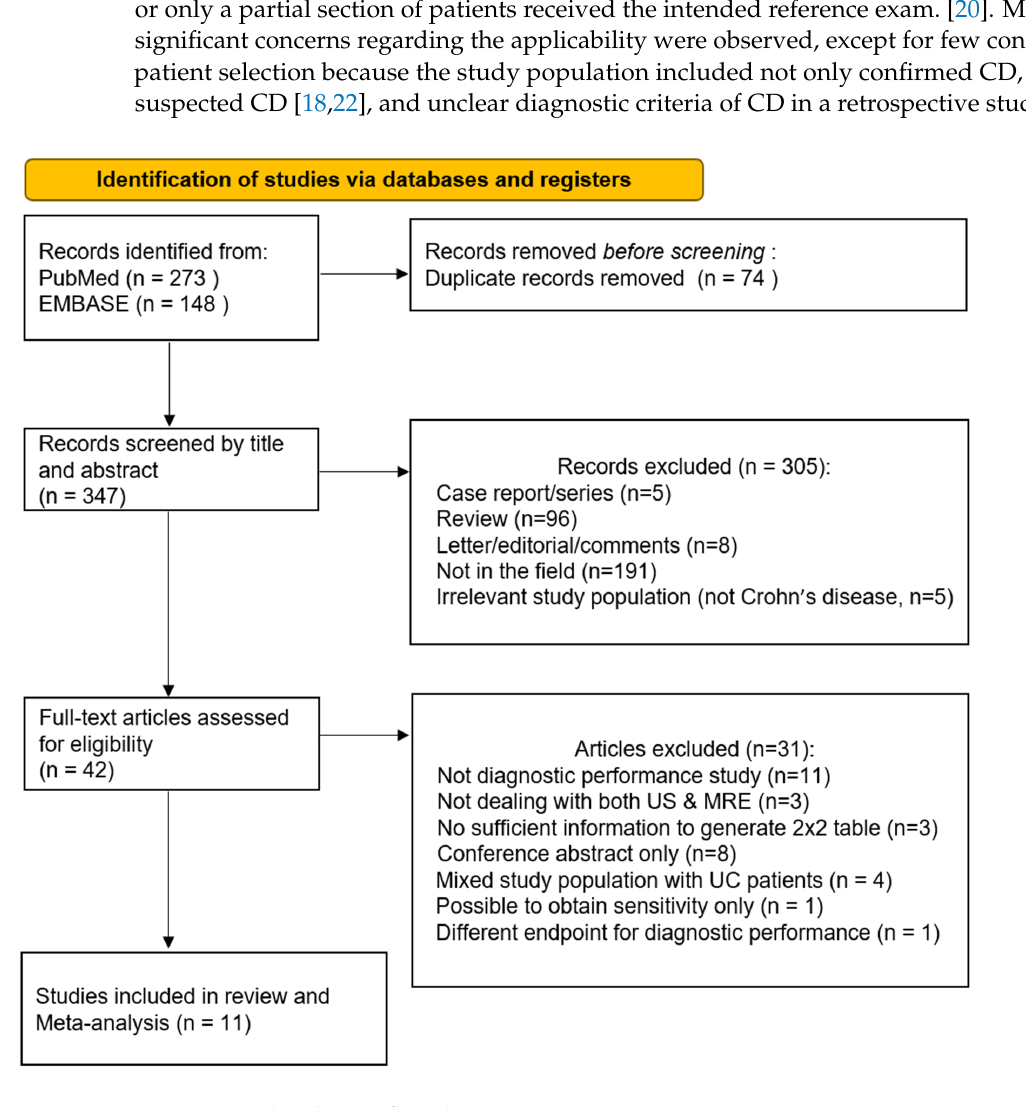
Figure 1. Study selection flow diagram.